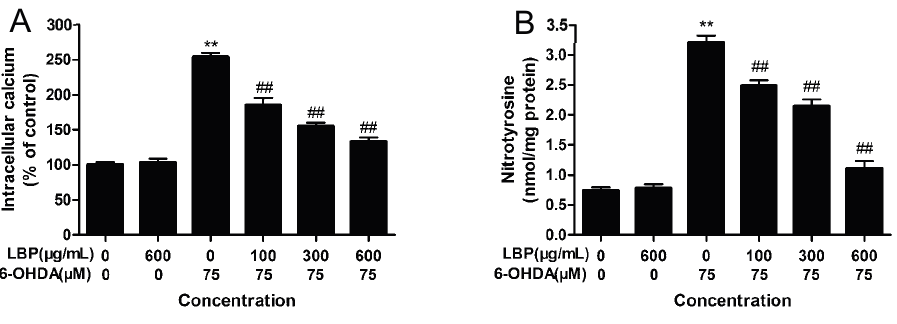
Figure 5. LBP attenuates the 6-OHDA-induced elevation of intracellular [Ca 2+ ] i ( A ) and protein-bound 3-NT ( B ) in PC12 cells.PC12 cells were exposed to LBP (100–600 μ g/mL) for 24 h before 75 μ M 6-OHDA was added to the medium for an additional 24 h. Data are expressed as percentage of untreated control cells ± SD ( n = 6). ** p < 0.01 compared with untreated control cells; ## p < 0.01 compared with 6-OHDA-treated cells.